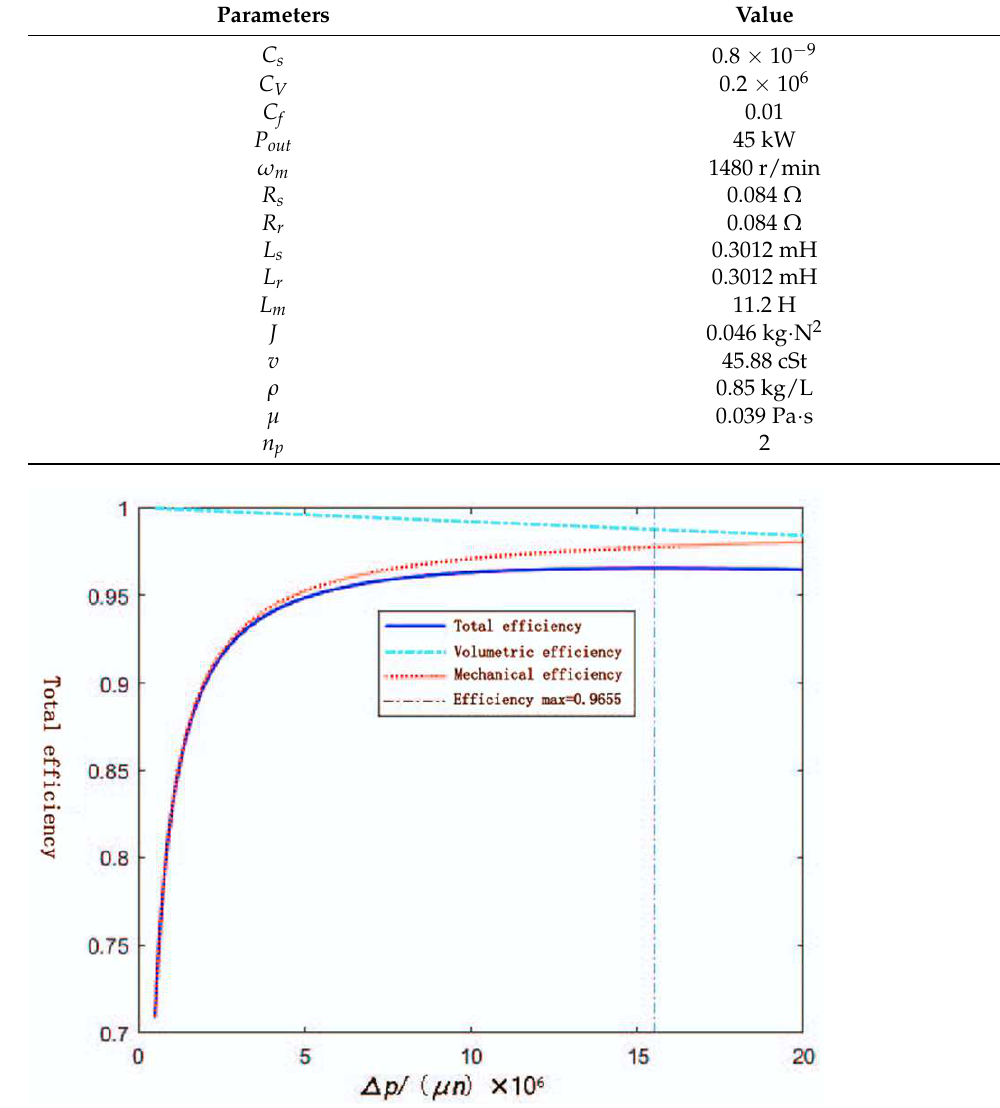
Table 1. The parameters of the values.